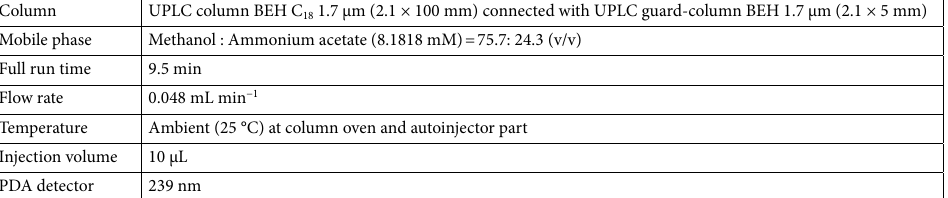
Table 1. Optimum chromatographic conditions for the RP-UPLC-PDA separation of oseltamivir phosphate/ dexamethasone/daclatasivir dihydrochloride/remdesivir mixture.